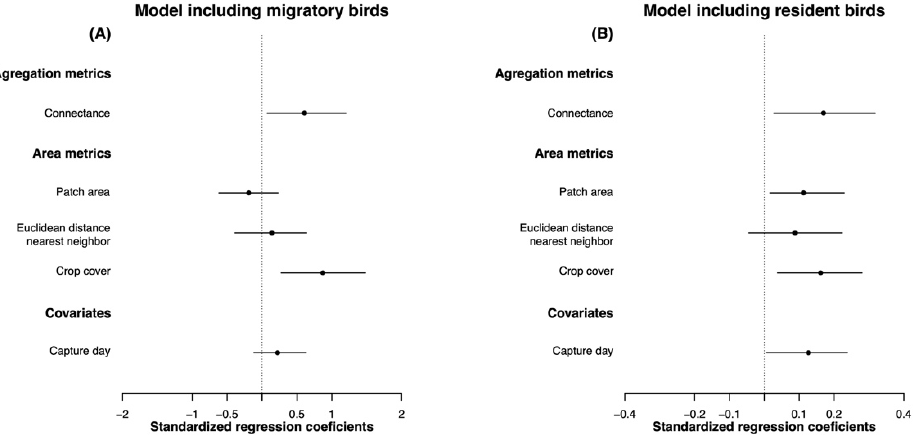
Figure 3. Standard regression coefficients obtained from the BLMM models for: ( A ) migrant species and ( B ) resident species. The dot represents the posterior mean, and the lines represent confidence intervals of 95%. We consider a given variable to have a statistically significant effect on body condition when the confidence intervals do not overlap with